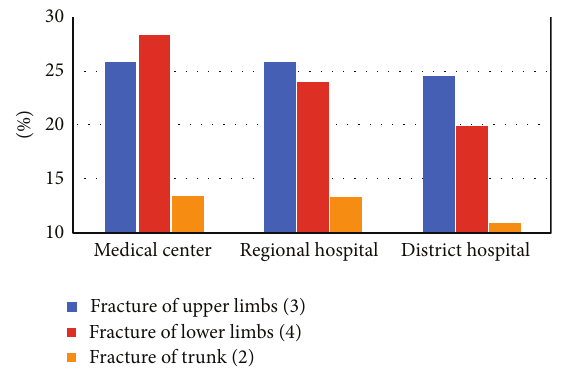
Figure 3: Percentage of three orthopedic fracture patterns of all the traffic accidents-related inpatients treated among three different level hospitals in Taiwan,